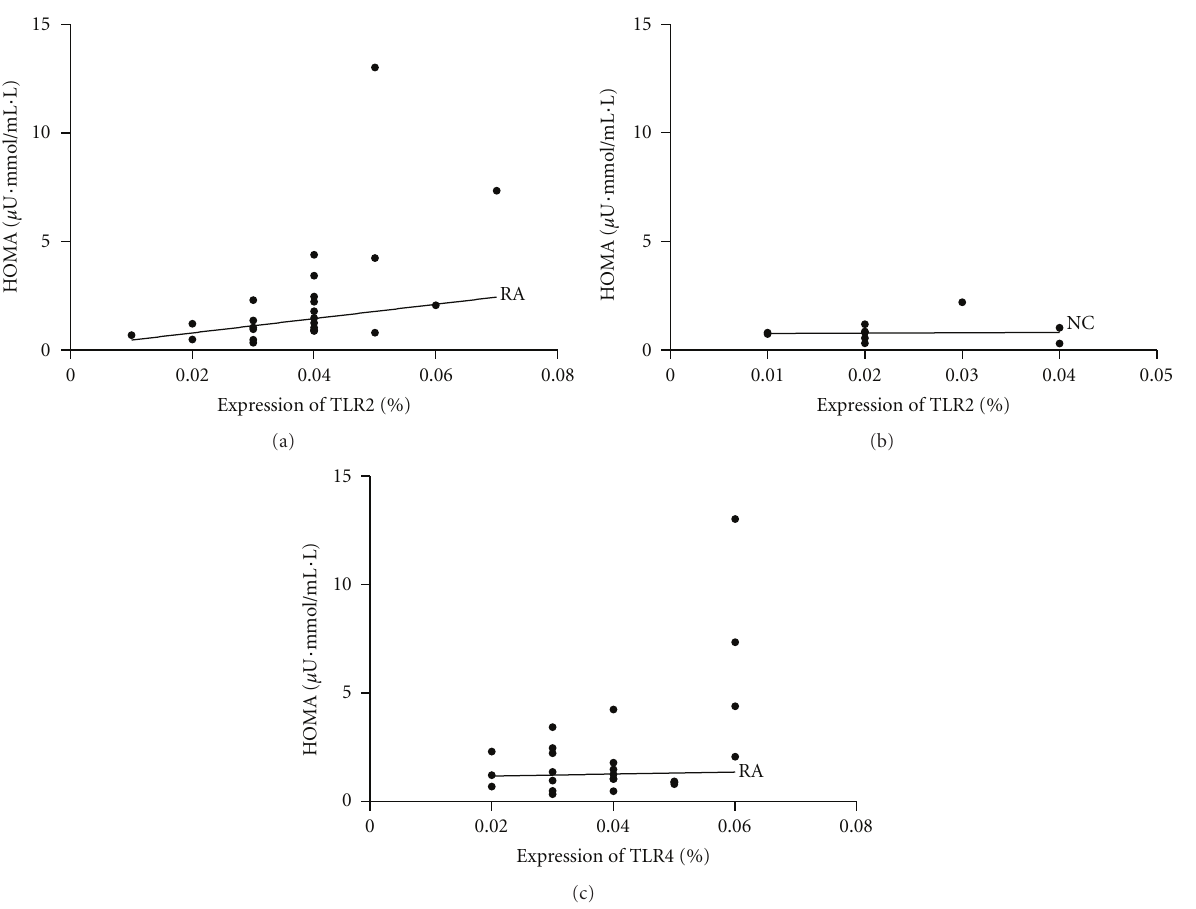
Figure 3: Relationship between HOMA index and TLR2 or TLR4 expression (calculated as percentage of CD14 + monocytes expressing TLR2 or TLR4) in monocytes after stimulation with peptidoglycan or lipopolysaccharide in RA patients and normal controls (NC). (a) Positive correlation between HOMA index and TLR2 expression after stimulation with 10 μ g/mL of peptidoglycan in RA patients ( r = 0 . 514, P = 0 . 009); (b) no significant correlation between HOMA index and TLR2 expression in normal controls ( r = 0 . 150, P = 0 . 682); (c) no significant correlation between HOMA index and TLR4 expression after stimulation with 10 ng/mL of lipopolysaccharide in RA patients ( r = 0 . 230, P = 0 .